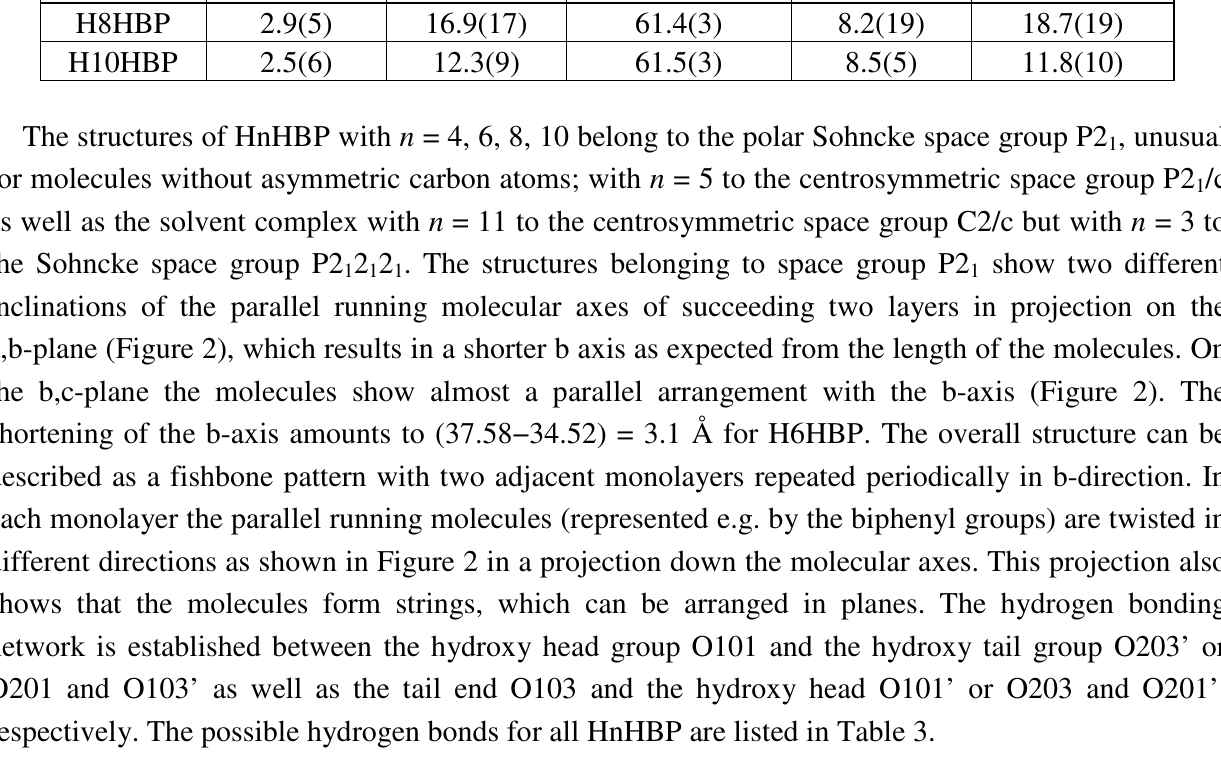
Figure 2. Representation of the packing arrangement of H6HBP, space group P2 projected in [001] and [100] direction and a projection along the molecular axes of one monolayer showing the differently oriented two molecules of the asymmetric unit. Similar patterns can be drawn for all HnHBP in space group P2